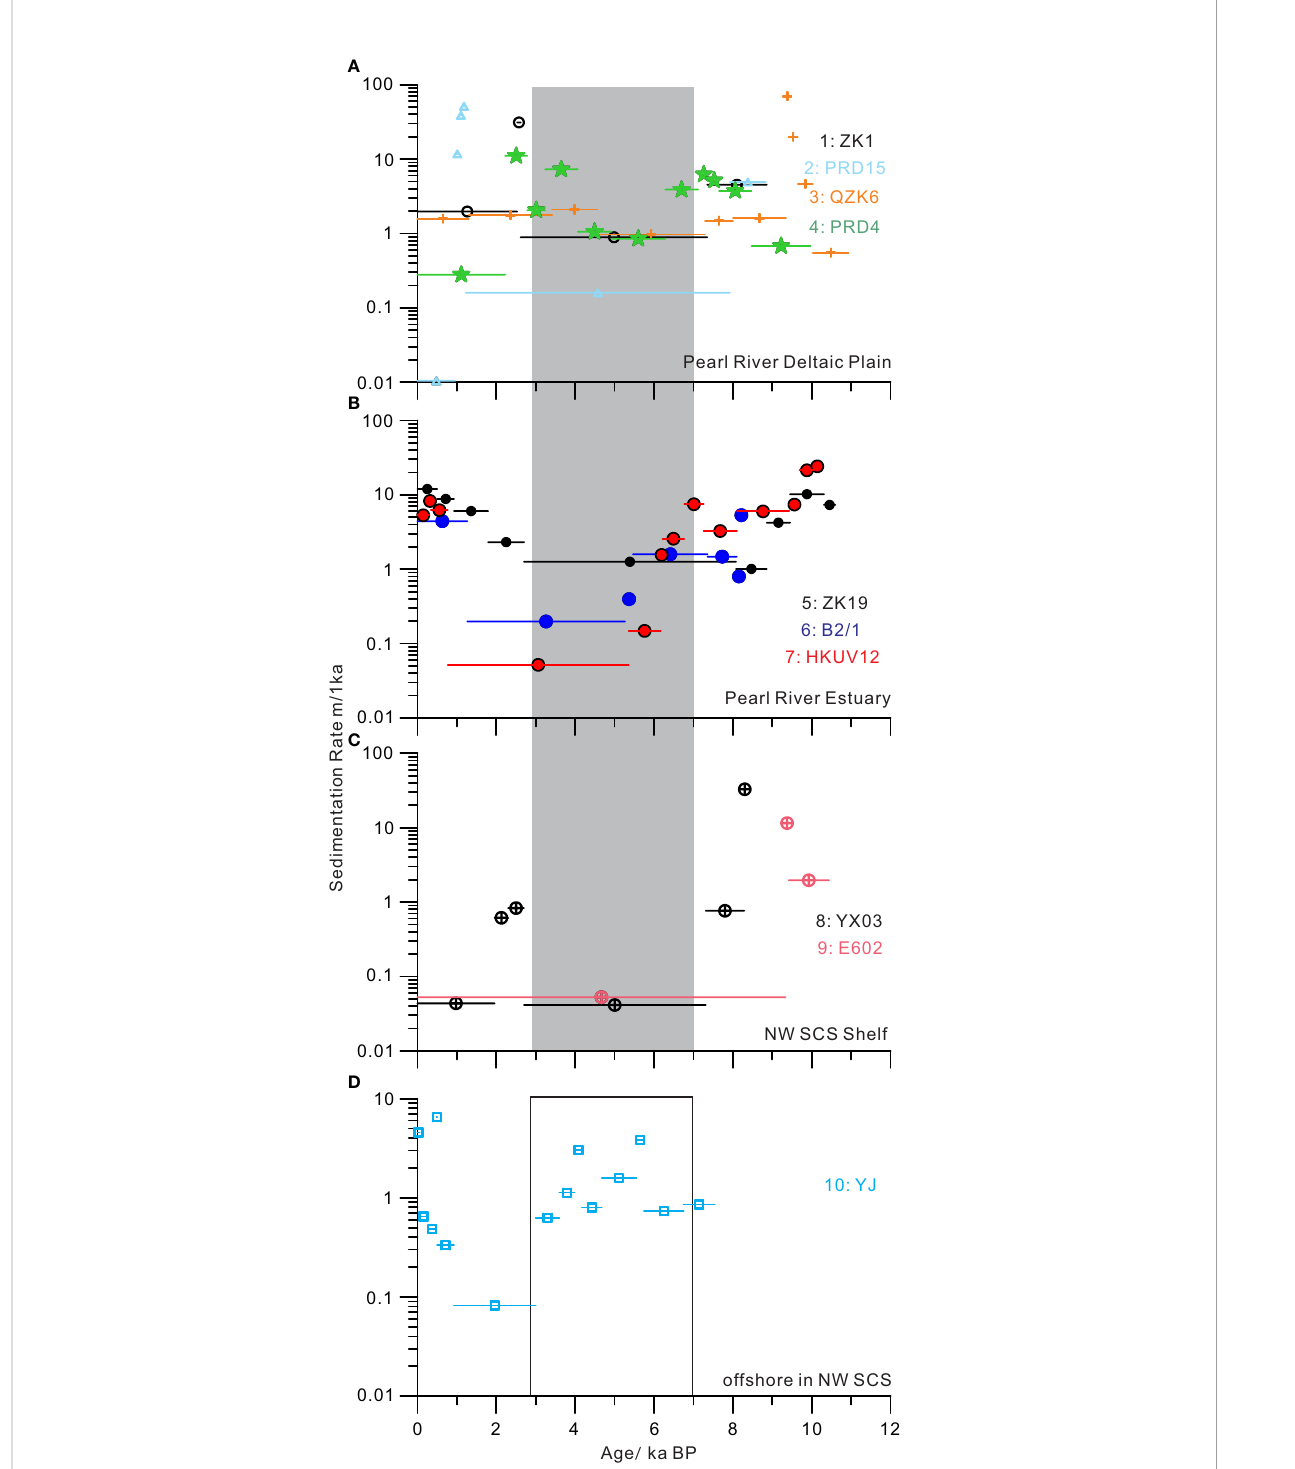
FIGURE 7 Sedimentation rates of marine deposits on the north-western SCS shelf during the past 12 ka BP. See Figure 1A for the locations of cores. Note that between ~3 and 7 ka BP the accumulation rates were low at the Pearl River delta and on the middle-and-outer SCS shelf. The low sedimentation rate during this period was not found in offshore waters. Reference cores were published by Yim et al. (2006); Hu et al. (2013); Xiao et al. (2013); Wei et al. (2016); Huang et al. (2018); Xiong et al. (2018); Chen et al. (2019) and Zong et al.